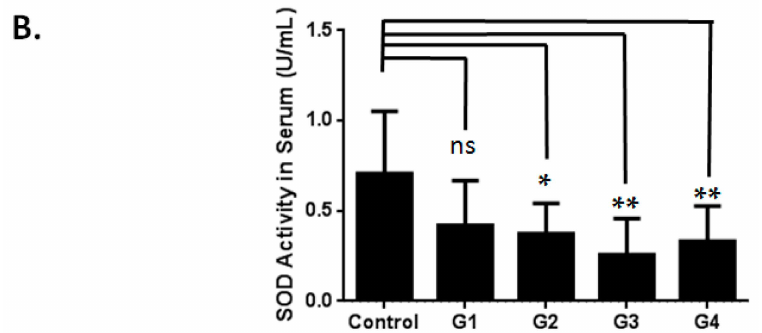
Figure 1. Model of male reproductive aging optimized through D -Galactose ( D -Gal) injections. ( A ) Mice divided into five groups: the vehicle group (Control: Phosphate-buffered saline, PBS, administered over eight weeks) and the D -Gal-injected groups, namely G1 ( D -Gal dosage of 100 mg/kg over six weeks), G2 ( D -Gal dosage of 100 mg/kg over eight weeks), G3 ( D -Gal dosage of 200 mg/kg over six weeks) and G4 ( D -Gal dosage of 200 mg/kg over eight weeks). The mice were injected intraperitoneally daily for six or eight weeks. The bars indicate the ages of the mice in weeks; ( B ) The serum of mice injected with D -Gal showed lower superoxide dismutase) SOD activity (SOD is a critical antioxidant enzyme) than did the serum of those administered PBS. One-way Analysis of variance (ANOVA) test: “ns” denotes nonsignificant; bars represent the mean ˘ SD; * p < 0.05; ** p < 0.01.